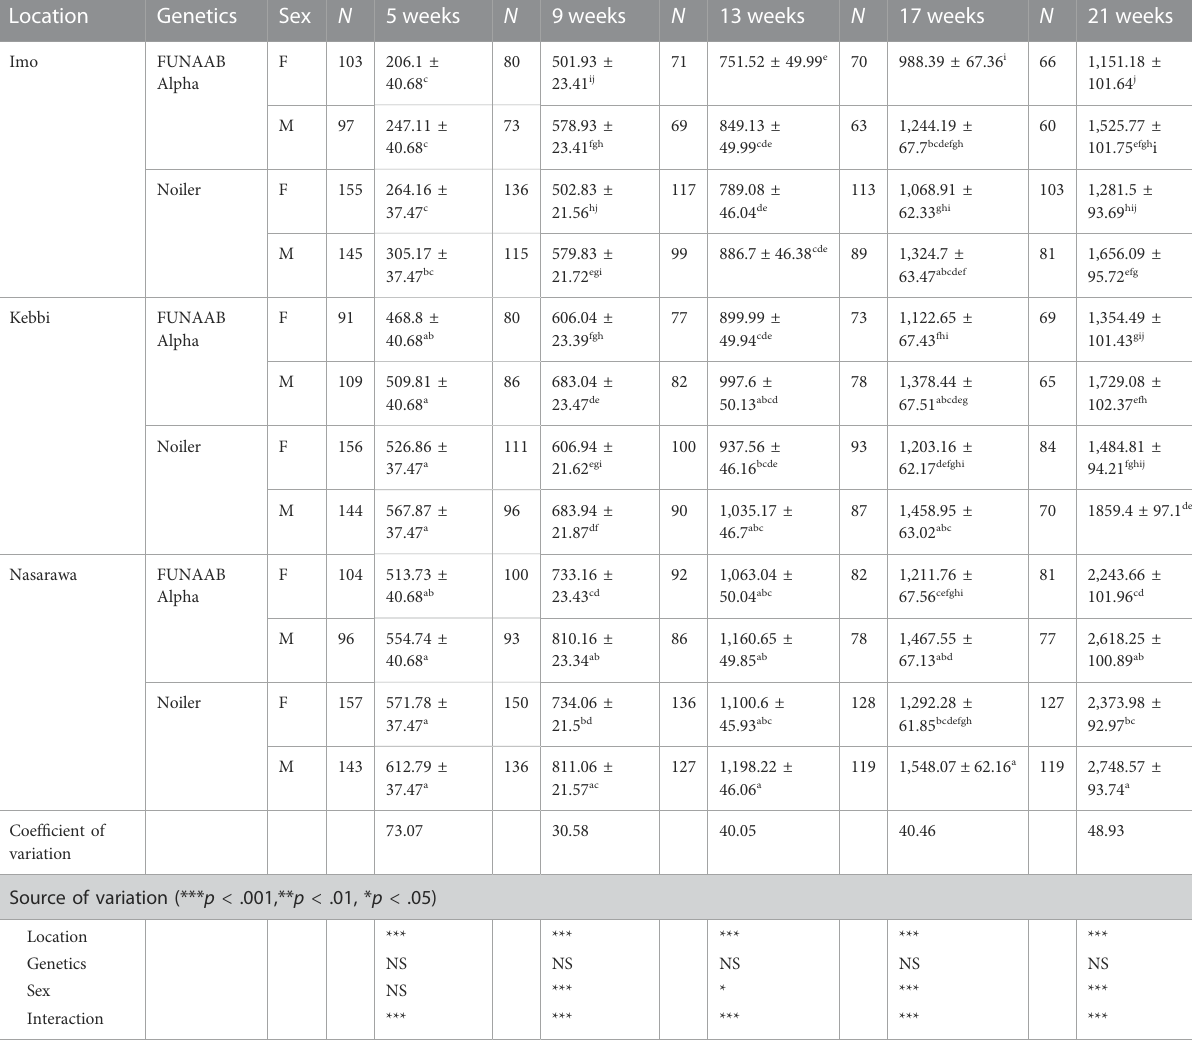
TABLE 3 Effects of location, genetics and sex on body weight (g) of the chickens (LSM ± SE).